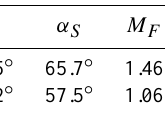
Table 3. Shock speed V S (in km/s), elevation θ S and azimuth φ S of the shock normal (RTN coordinates), angle α S between upstream magnetic field and shock normal, and fast magnetosonic Mach num- ber M F .